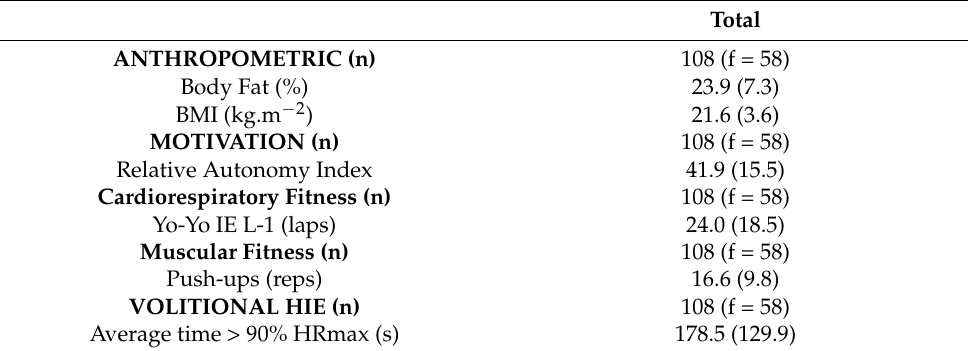
Table 1. Descriptive statistics of study variables (mean ±